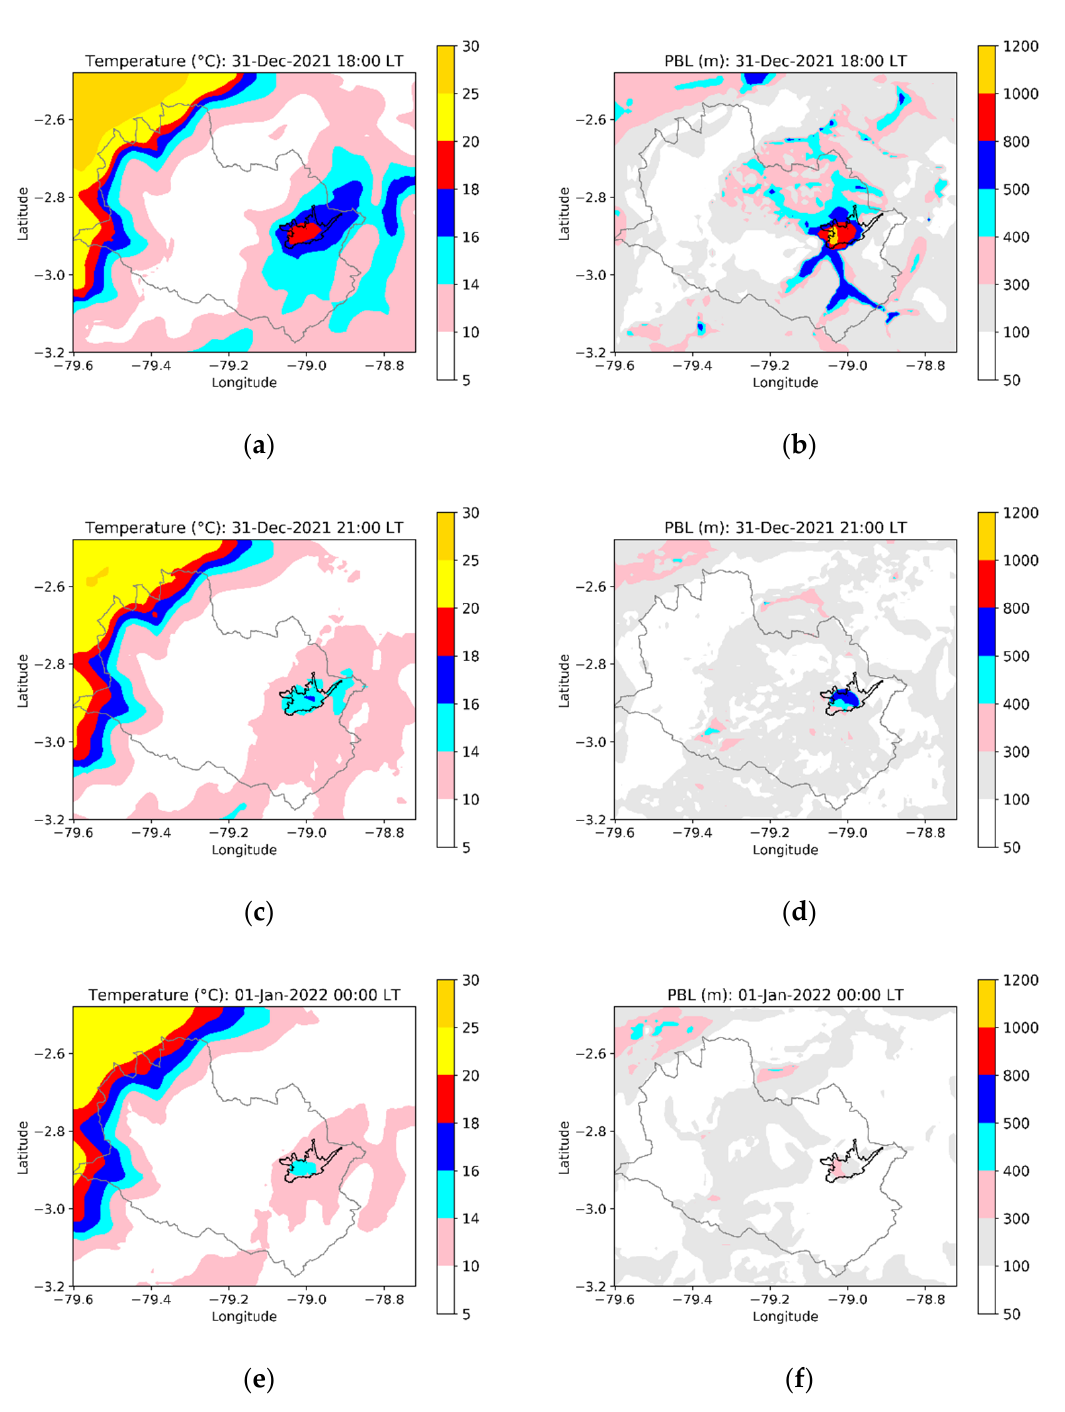
Figure 7. Modeled maps of temperature and planetary boundary layer (PBL) depth for selected hours: 31 December 2021 at 18:00 LT ( a , b ), 31 December 2021 21:00 LT ( c , d ), and 1 January 2022 at 00:00 LT ( e , f ).